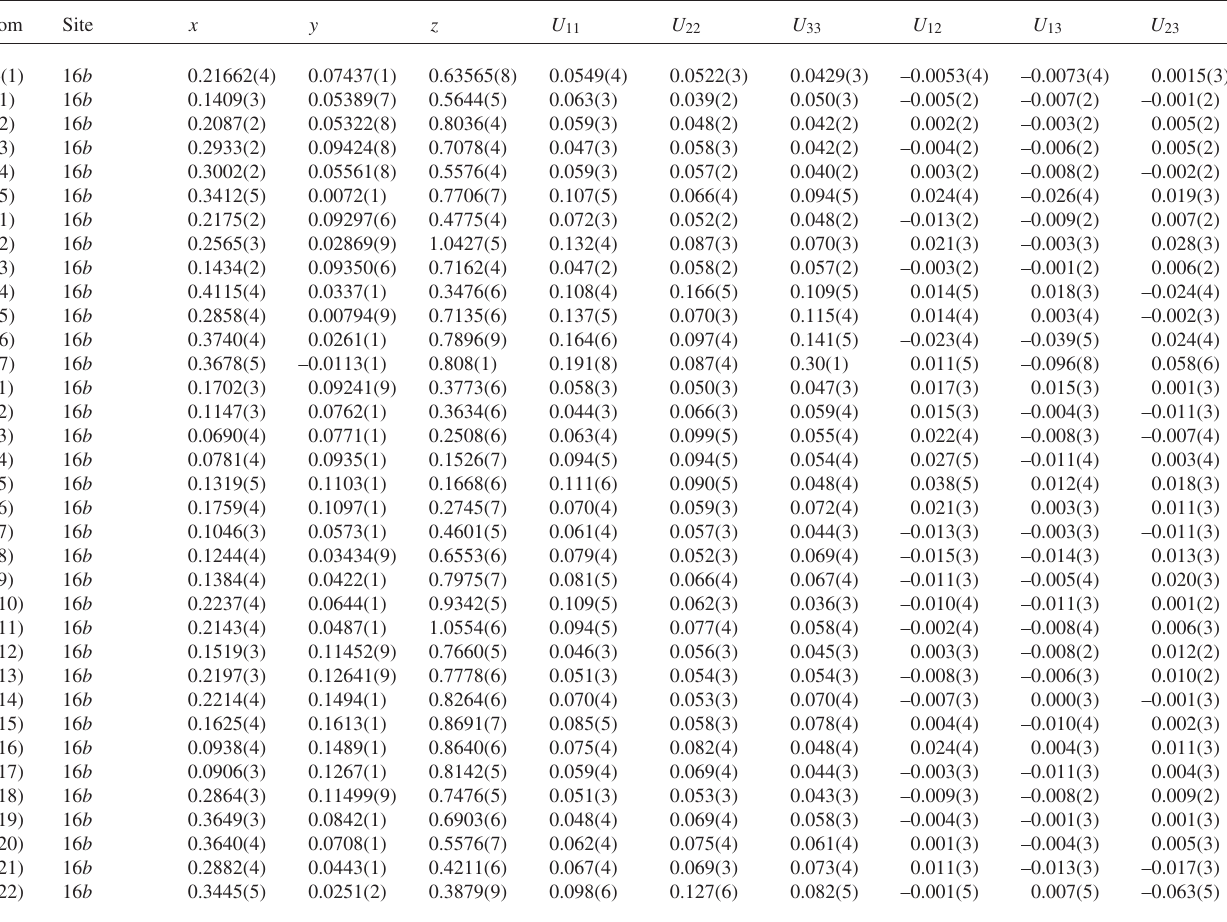
Table 3. Atomic coordinates and displacement parameters (in Å 2 )